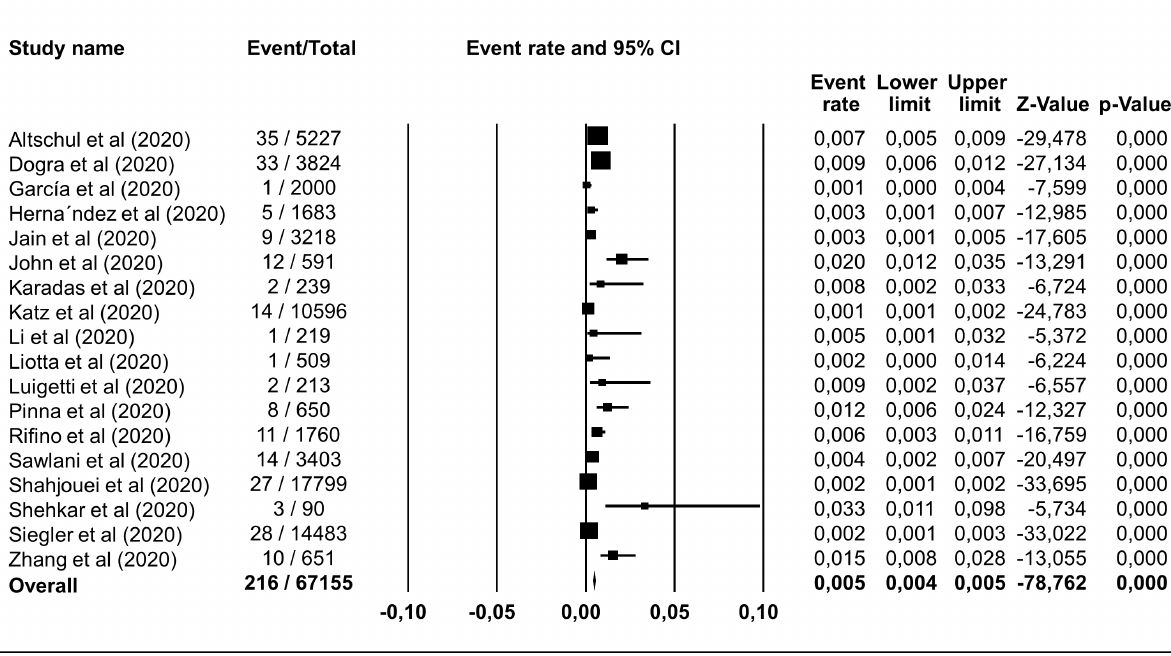
Figure 2. Forest plot of the prevalence of haemorrhagic stroke in COVID-19 patients. The pooled estimate of haemorrhagic stroke prevalence is 0.46% with 95% CI 0.40%–0.53%, p<0.0001; p-value for Egger and heterogeneity is 0.882 and <0.0001, respectively with I 2 89.81%.